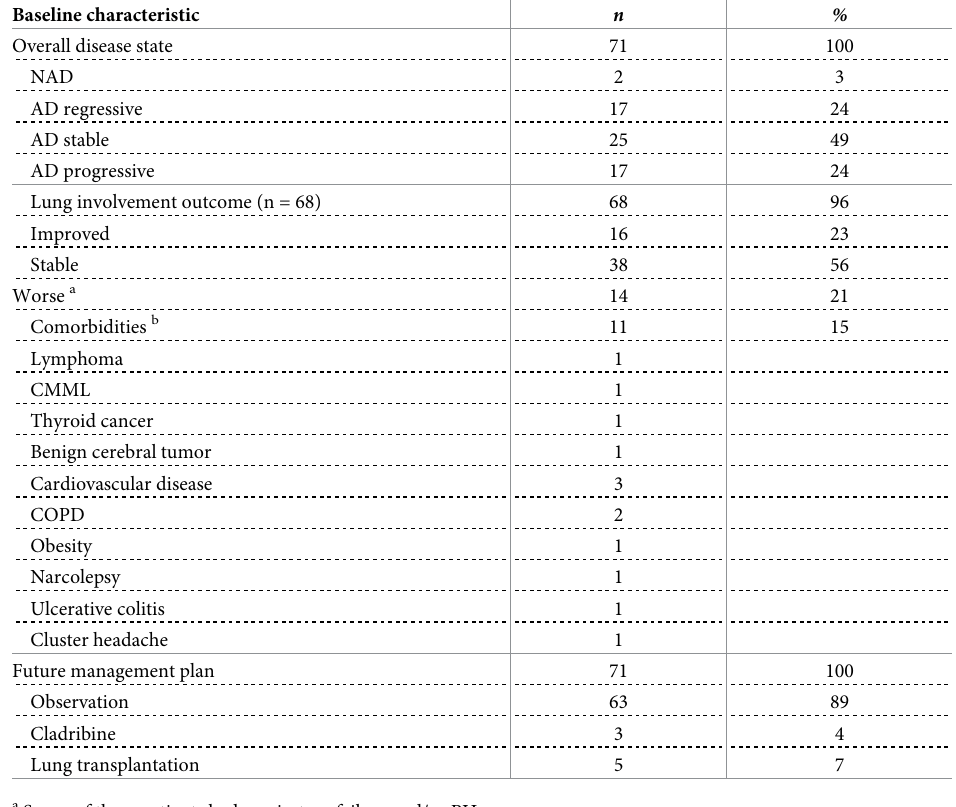
Table 2. Disease state at the time of inclusion in the study of the 71 LCH patients. Baseline characteristic